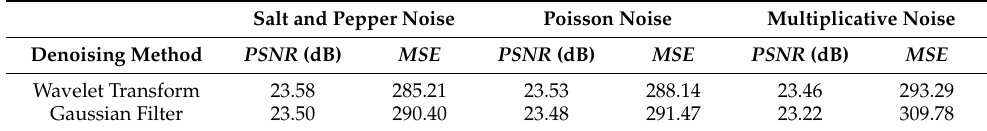
Table 4. Treatment results for three similar